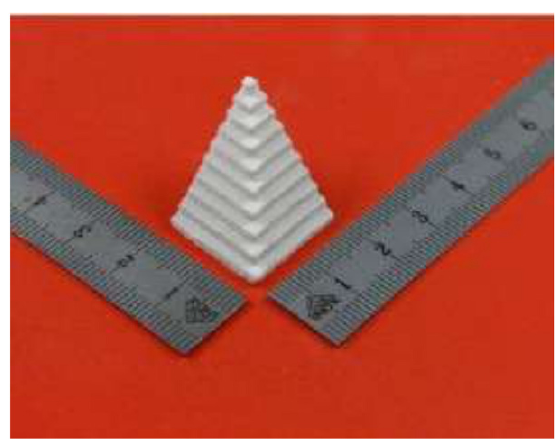
Figure 9. 3D calcium phosphate scaffold fabricated by using powder- based 3D printing [52].